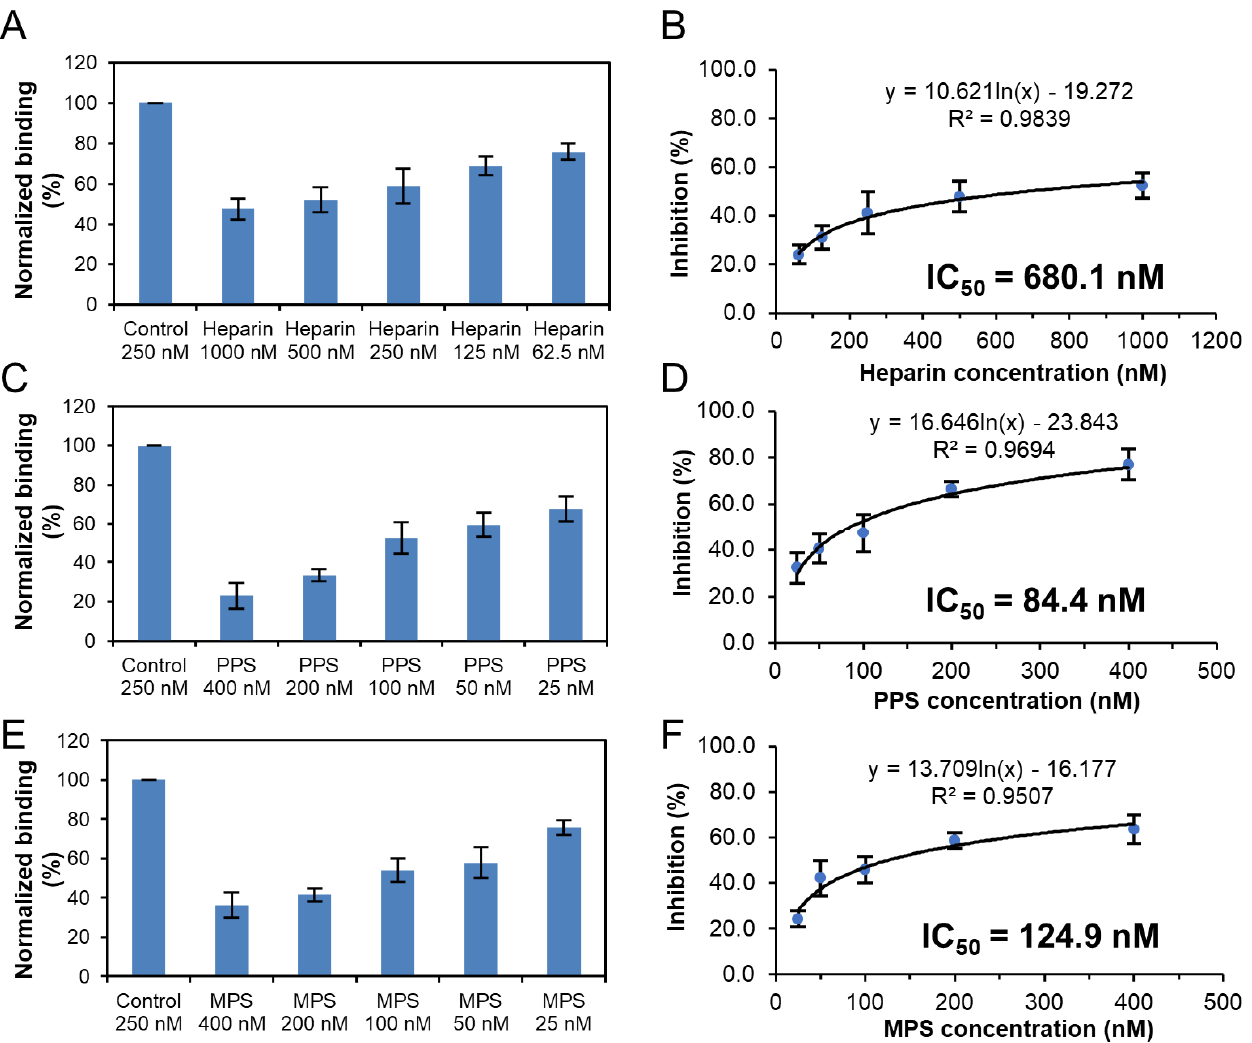
Figure 7. IC 50 measurement of the inhibition of S-protein RBD (BA.2.12.1) binding to heparin using solution competition SPR by sulfated glycans (heparin, PPS, and MPS). S-protein RBD concentration was 250 nM. Error bars represent standard deviations from triplicate tests. ( A , B ) = heparin; ( C , D ) = PPS; ( E , F ) = MPS.